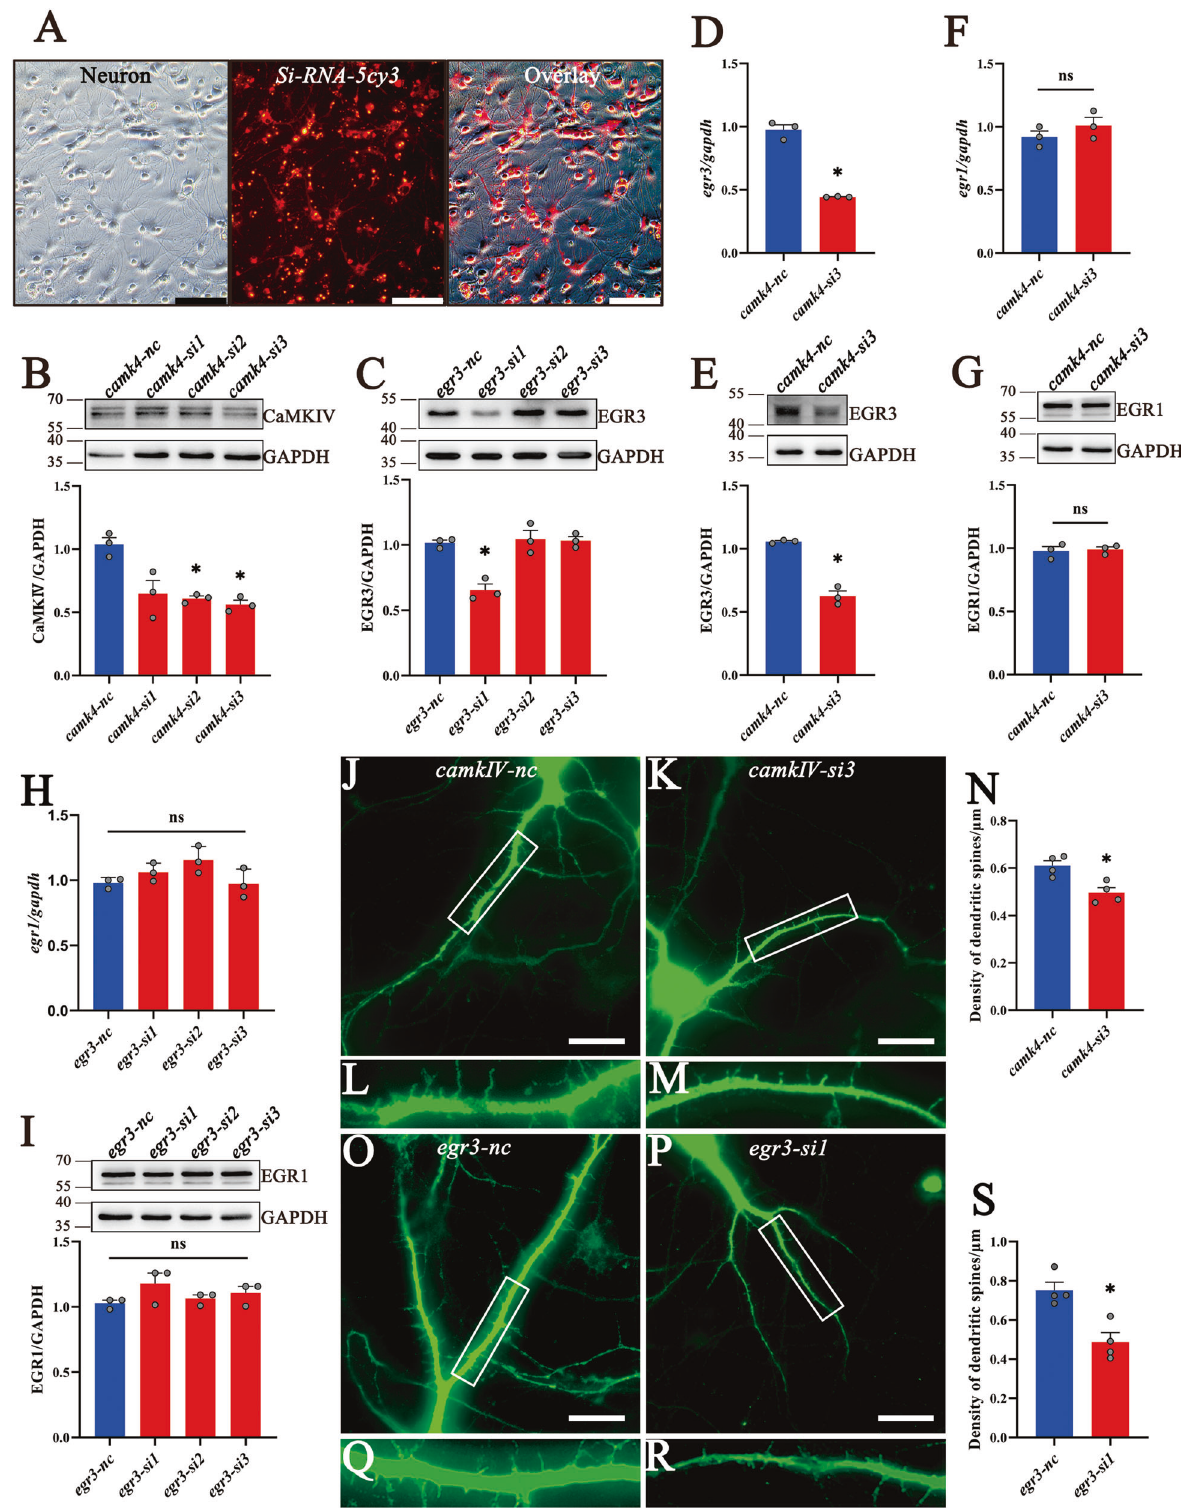
of BDNF in fl uences neurite development, synapse formation, and stabilization of CNS neurons, which are associated with multiple diseases of CNS, even postnatal death [65 – 67]. BDNF is highly expressed and released in the cerebral cortex, hypothalamus, striatum, cerebellum, and especially in the hippocampus of